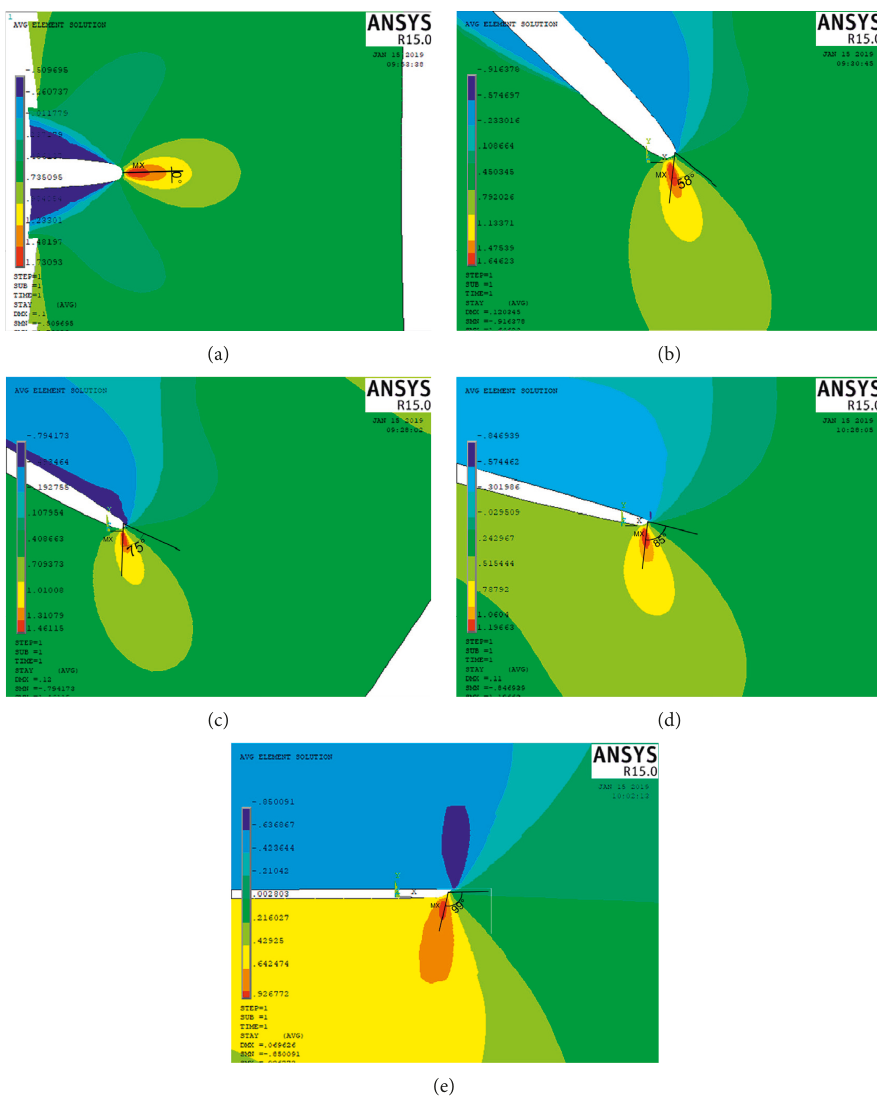
� 90 ° ), (b) mixed mode I/II eq